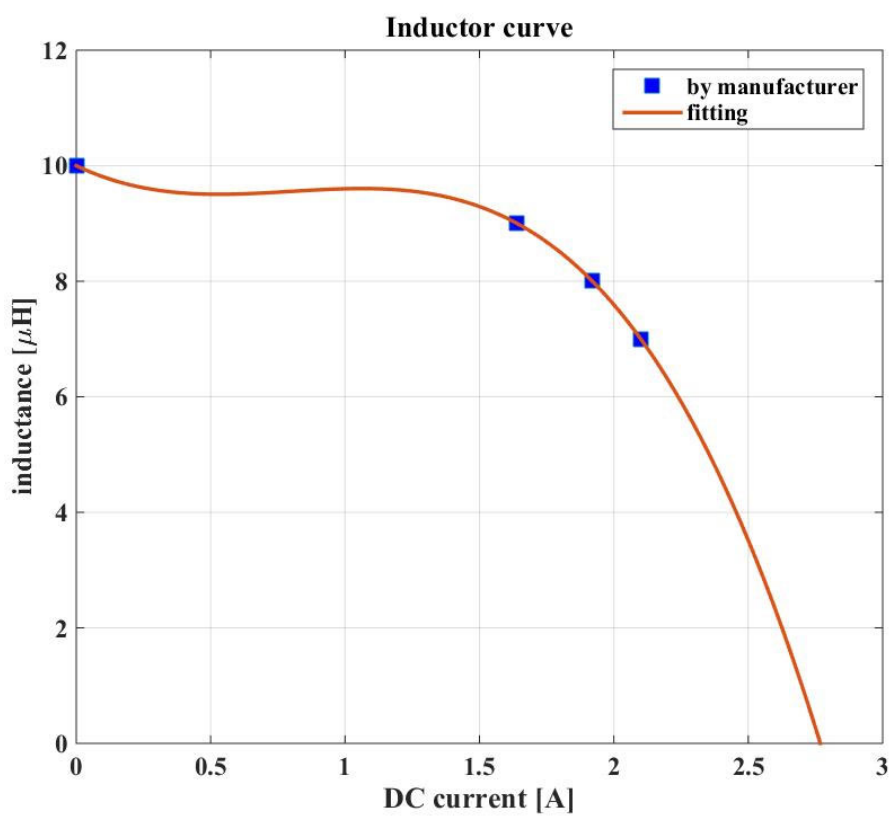
Figure 4. Characteristic curve obtained from manufacturer’s data.